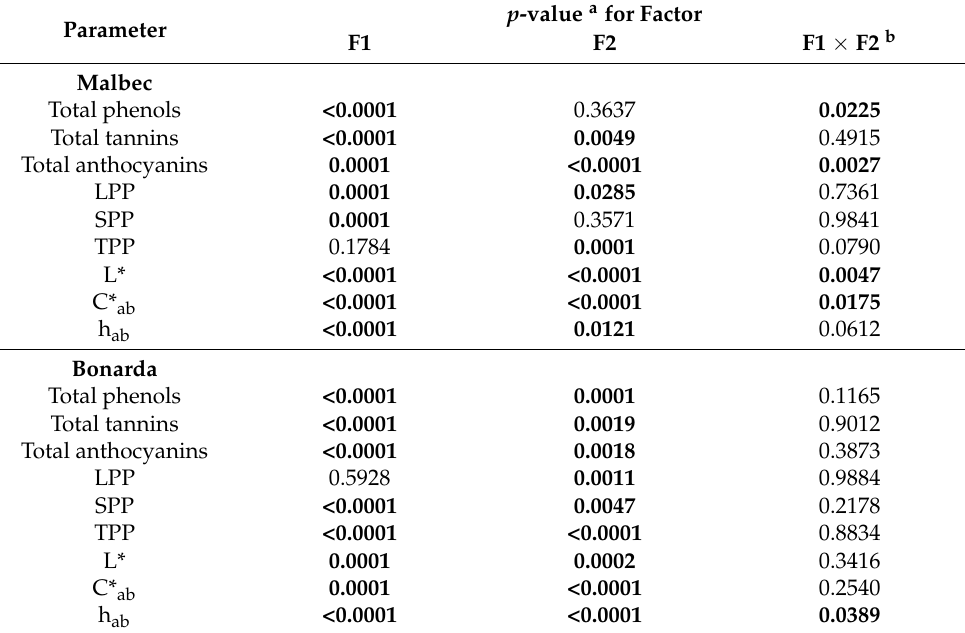
Table 4. Probability values (two-way ANOVA) for aging time (F1) and vine-shoot treatments (F2) to the global phenolic and color parameters in Malbec and Bonarda wines (Experiment